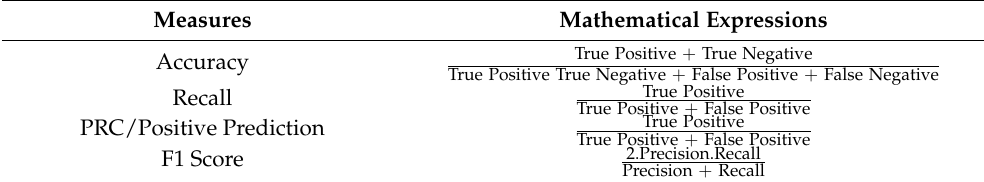
Table 2. Performance evaluation metrics.